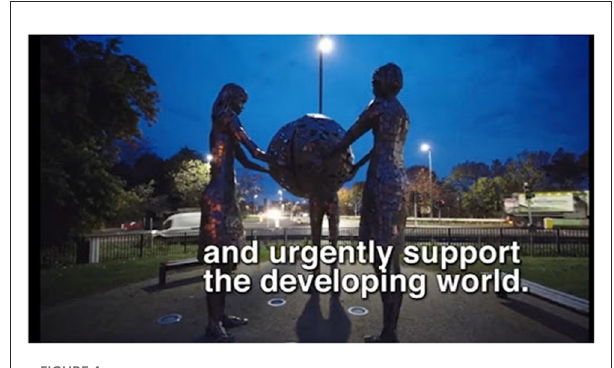
FIGURE4 Clip 1, Interacademies call for solidarity, 2020. Click on the following link for full video https://www.youtube.com/watch?v=8loi5JECDNk.